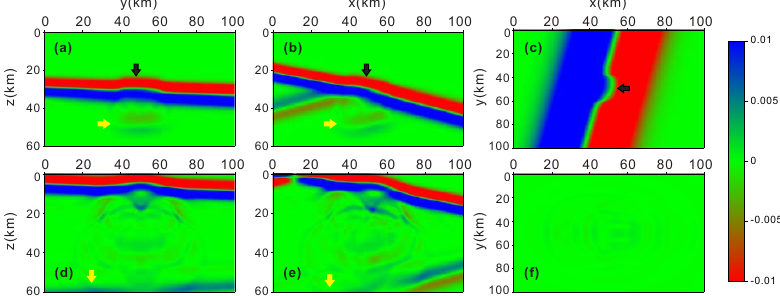
Figure 6. Snapshots in a heterogeneous model. The snapshots in the upper and lower panels are taken at t = 18 and 22s, respectively. The left, middle, and right panels are snapshots of planes at x = 50km, y = 50km, and z = 30km, respectively. The black arrows in the upper plots indicate the distortion of the wave front because of the velocity anomaly in the media. The yellow arrows in (a) and (b) indicate the scattered waves. The yellow arrows in (d) and (e) denote the scattered waves that are efficiently absorbed by the constructed PML ABC. The color scale is shown on the right side of the